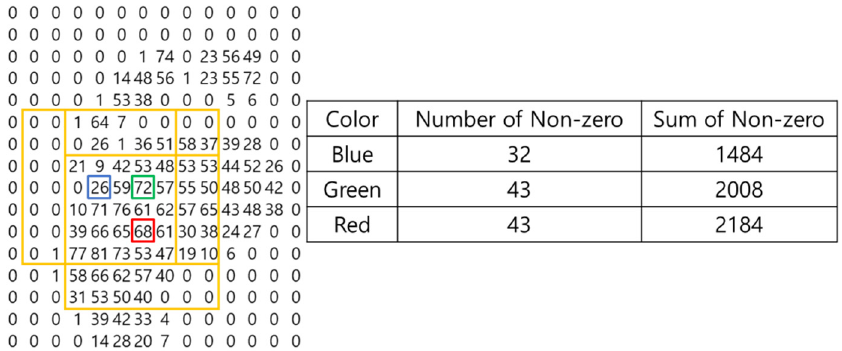
Figure 5. Locating a candidate center of gravity.